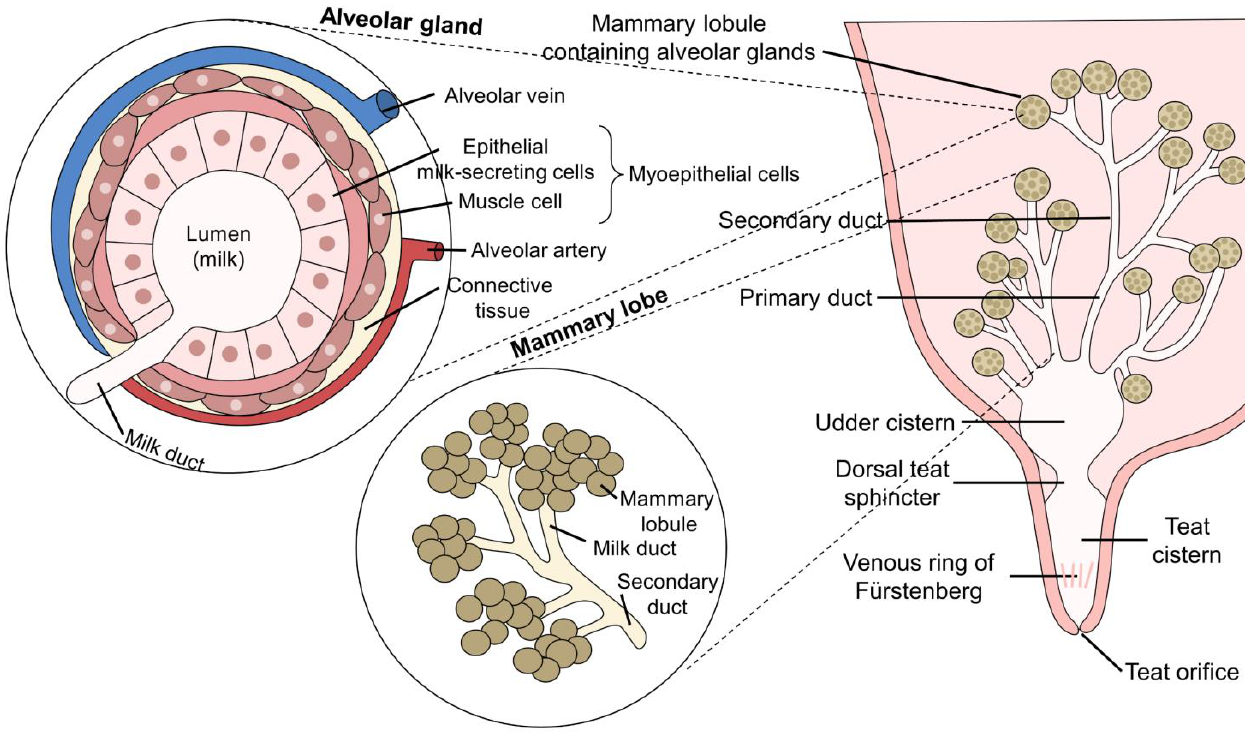
Figure 2. Anatomy of the water buffalo’s mammary gland. Sagittal cut of a mammary complex showing the system of lobules with their alveolar glands, enlarged alveolar glands, excretion ducts, and milk storage area.